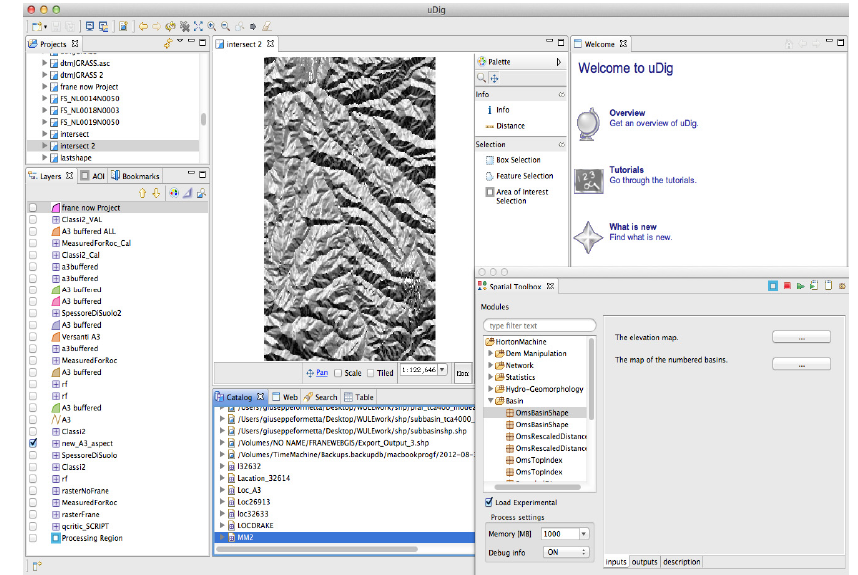
Figure 1. The OMS Console: OMS components can be linked and executed or automatically calibrated.